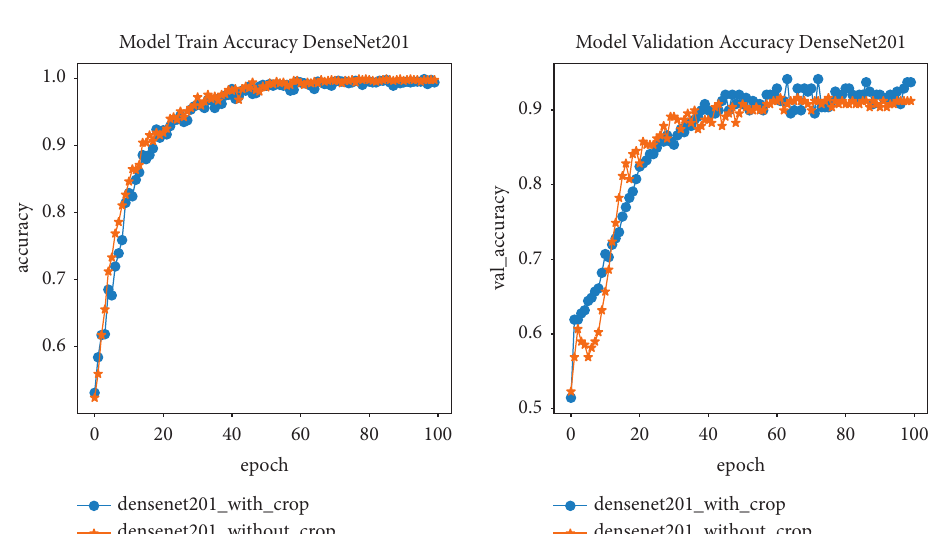
Figure 6: Accuracy of DenseNet201 network architecture before and after normalization.